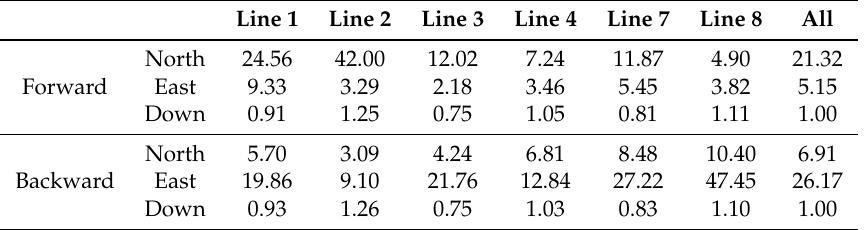
Table 4. Repeatability results of repeat lines